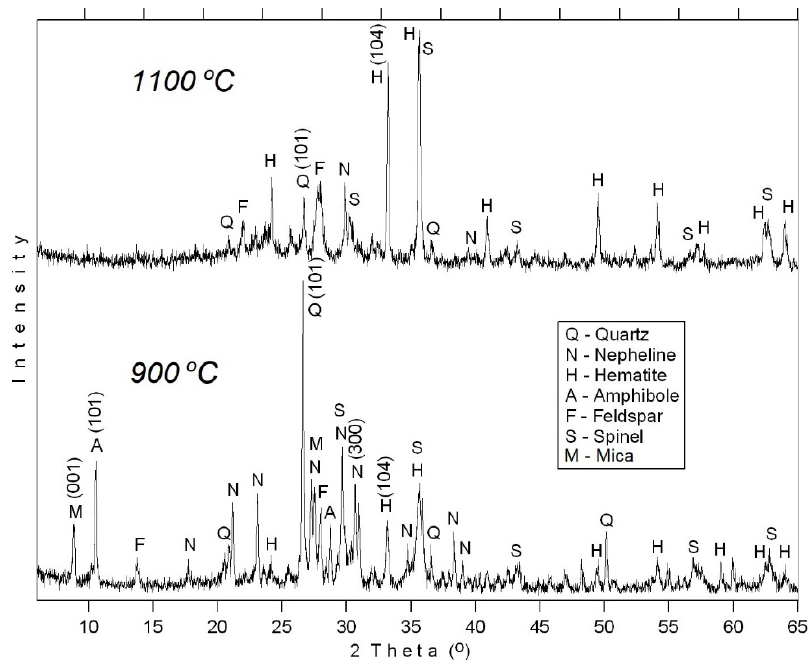
Figure 1. XRD patterns of a ceramic sample fired at different temperatures. The Miller indices (hkl) are indicated for peaks used for the graph in Figure 2.